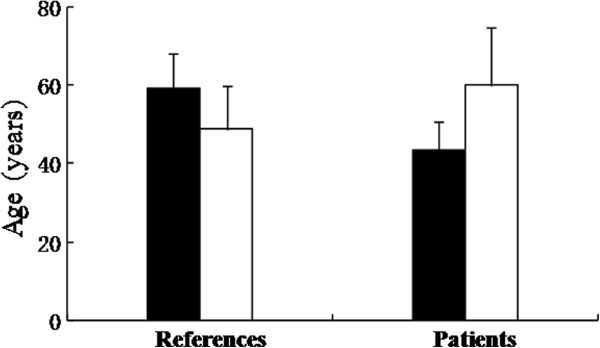
Average ages of the esophageal carcinoma patients and references with SXCI defined by CR ≥ 3 (filled bar) and without SXCI (empty bar). Their standard deviations denoted on each bars. The differences in both the control and patient groups are statistically significant, with their P values below 0.05 and 0.005, respectively.